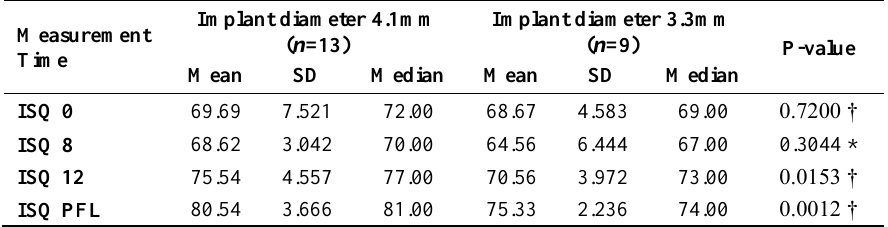
Table 4: The differences in implant in relation to DI diameter